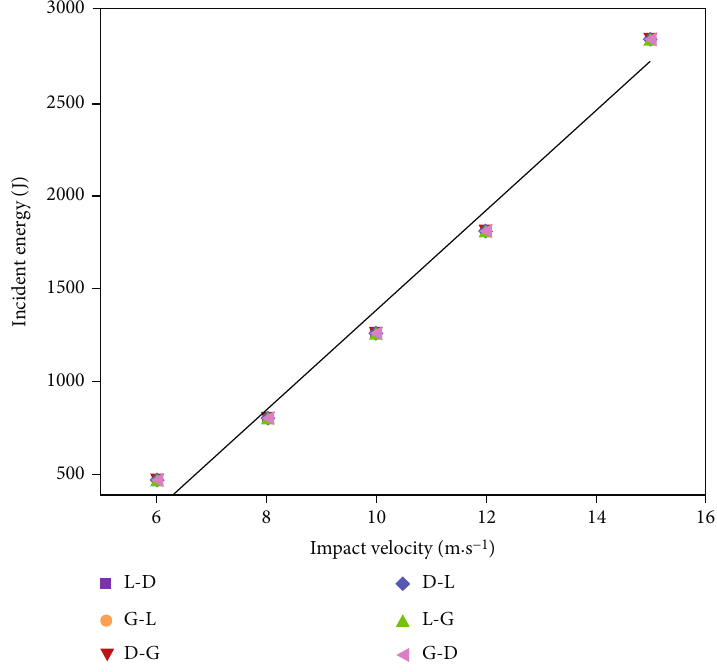
Figure 5: The relationship between incident energy and impact